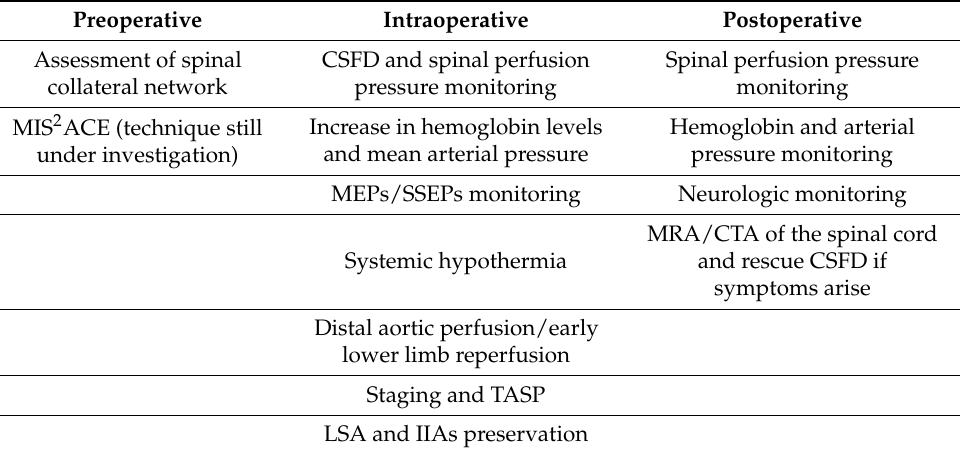
Table 2. Suggested strategies for spinal cord ischemia protection during